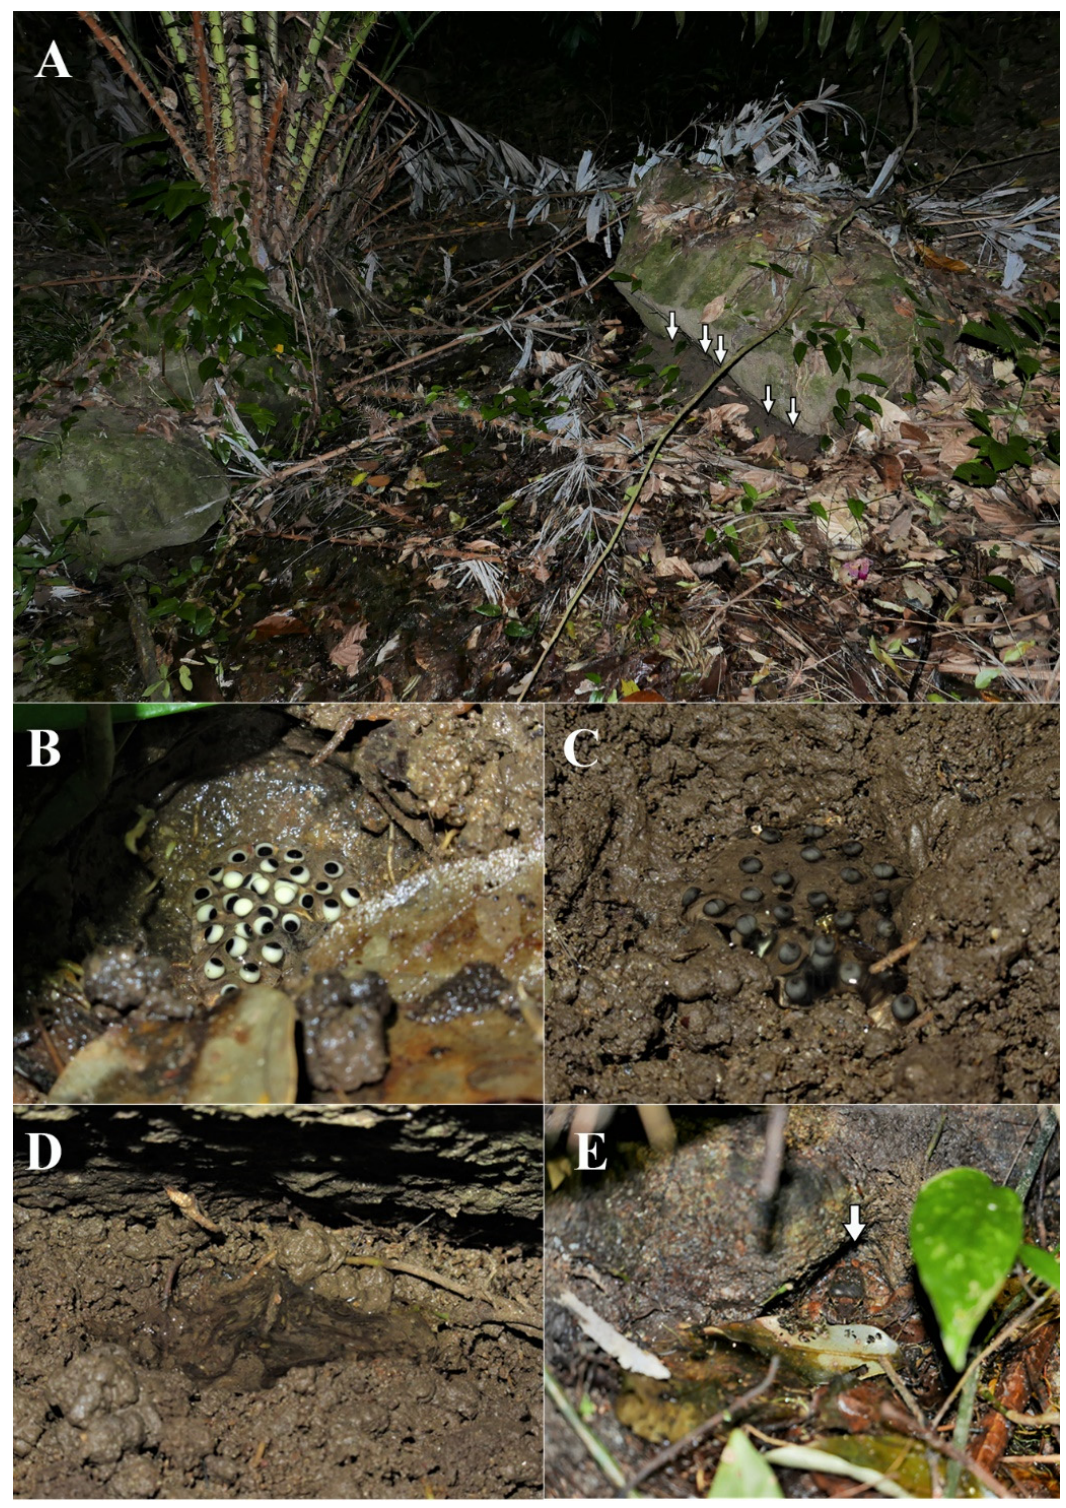
Figure 11. ( A ) Oviposition site of Limnonectes pseudodoriae sp. nov . at Song Reau Waterfall, Ko Samui Island, Surat Thani Province, ( B ) clutch of 30, bicolored eggs in a nest without free water, ( C ) clutch of 25 developing eggs, ( D ) 16 tadpoles in a small volume of fluid, and ( E ) adult male near the oviposition site (not collected).